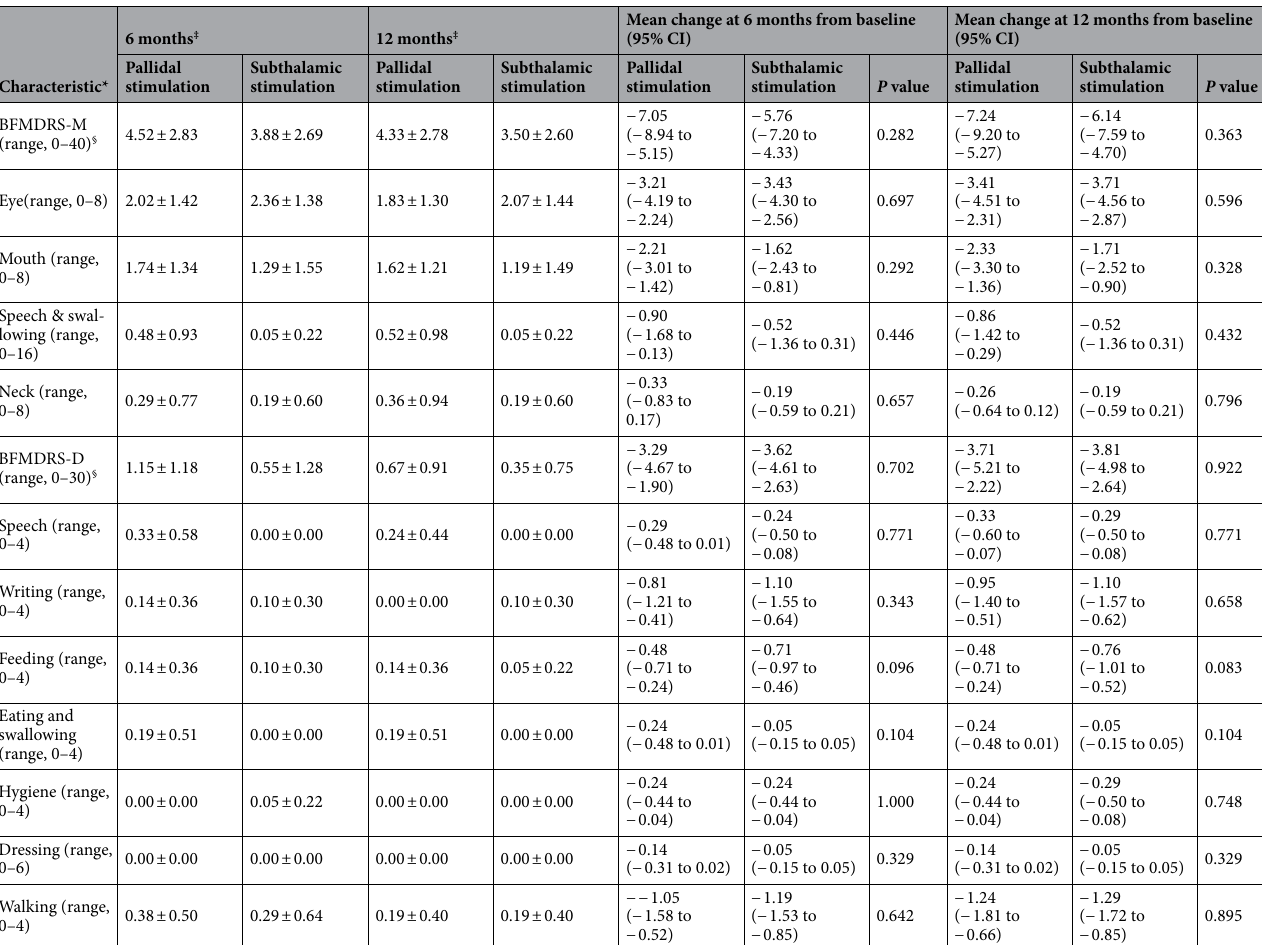
Table 3. Primary Outcome at 6 and 12 Months. *Plus–minus values are means ± SD. ‡ Assessments with DBS on. § A higher score indicates worse